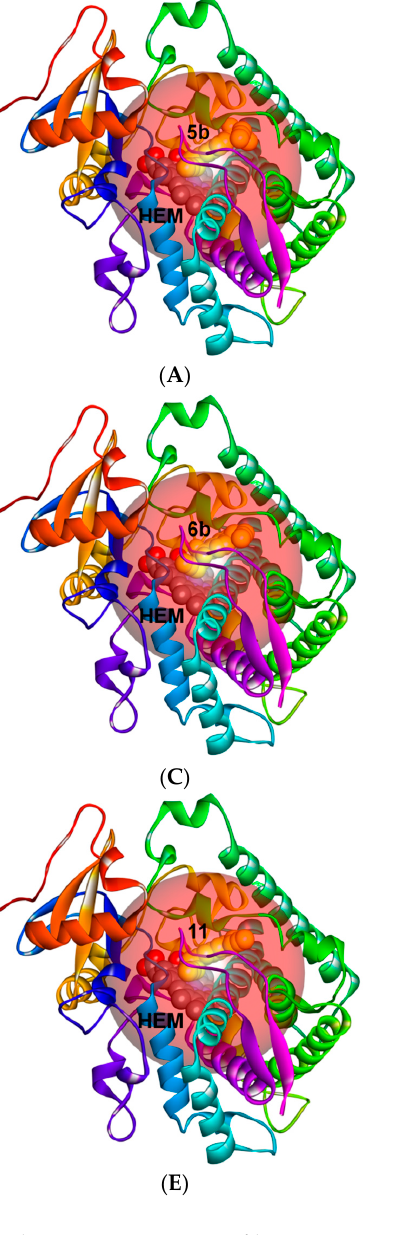
Figure 1. The tertiary structure of human CYP1A1 complexed with compounds 5b ( A ), 6b ( C ), and 11 ( E ), and a closer view of the orientation of compounds 5b ( B ), 6b ( D ), and 11 ( F ) inside the active site, near the heme–iron center. The protein’s backbone and active site are rendered as ribbon and green mesh, respectively.